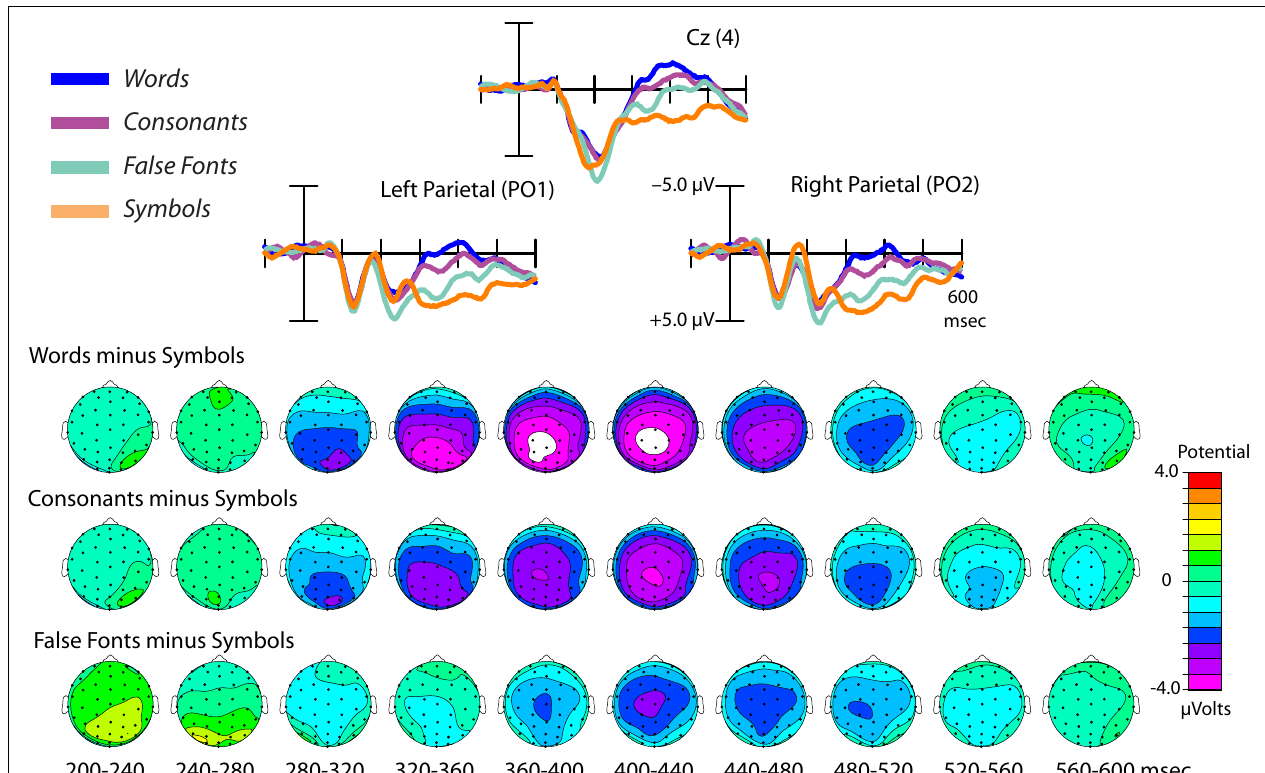
fonts > symbols), activity differences likely corresponding to modulations of the linguistically related N400 component. Bottom: The topographic distributions of the difference waves, relative to symbol strings, for each stimulus type, shown as spline-interpolated fl at